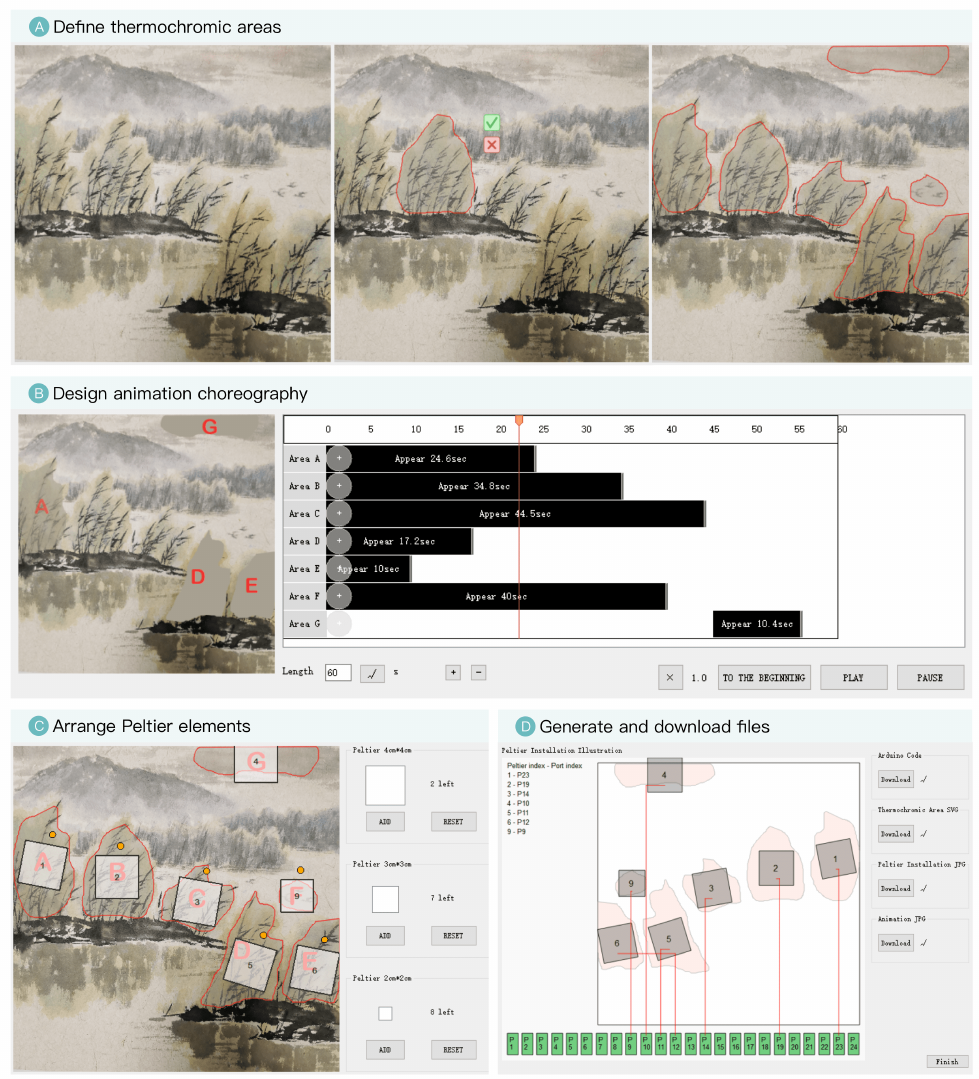
Figure 4. The step-by-step user interfaces and workflow of the design tool: (( A ), top) users easily design areas that need to have a thermochromic effect; (( B ), middle) users design and preview the choreographing animation; (( C ), bottom left) users can try different layout designs of three types of Peltier elements; (( D ), bottom right) users download three files to facilitate the creation process: an SVG line-drawing file to process the thermally conductive layer, a piece of Arduino code to control heating/cooling, and a Peltier installation